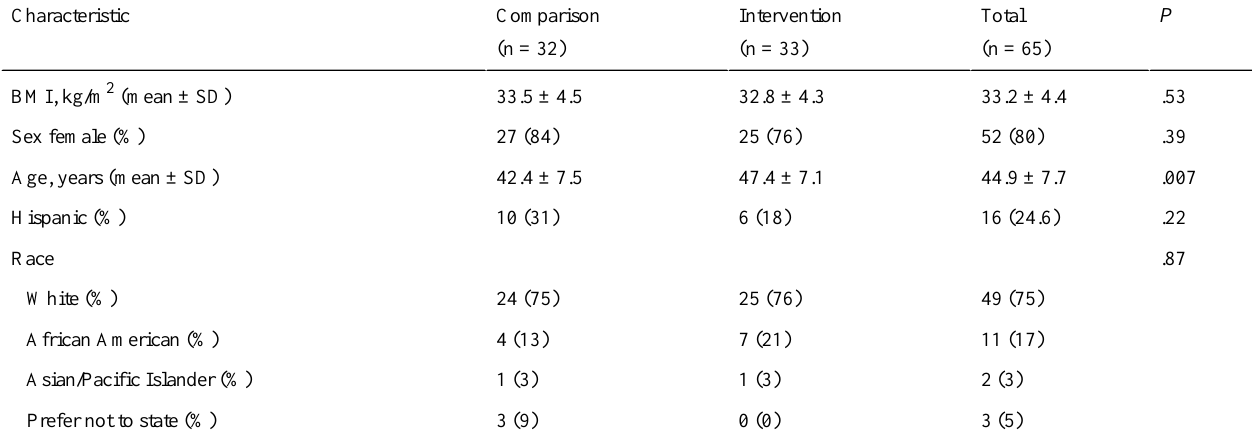
Table 2. Sample participant characteristics